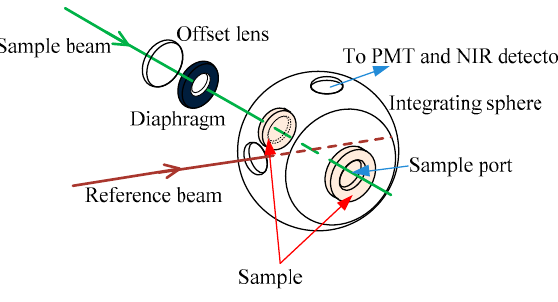
Figure 4. Schematic of spectral measurement.